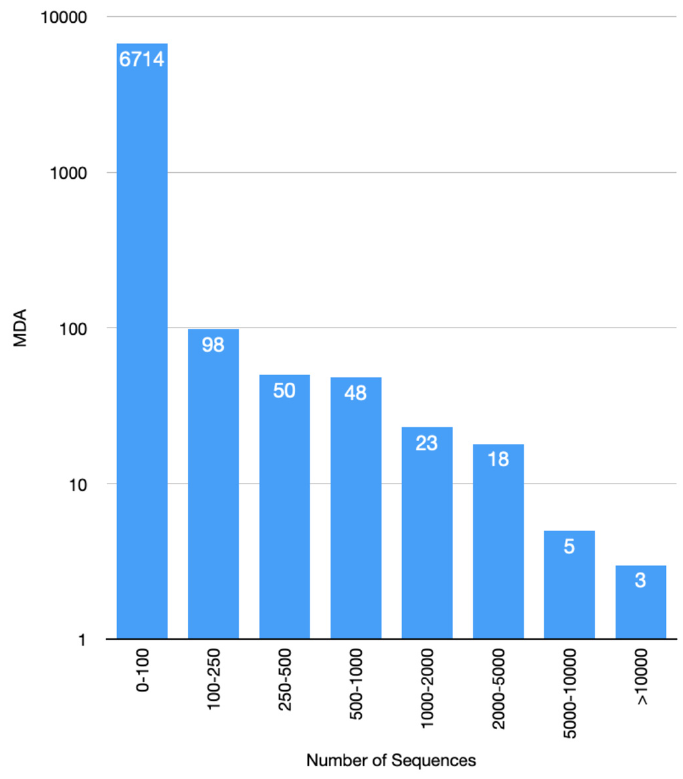
Figure 3. CATH kinase sequence distribution by multi – domain architecture (MDA).